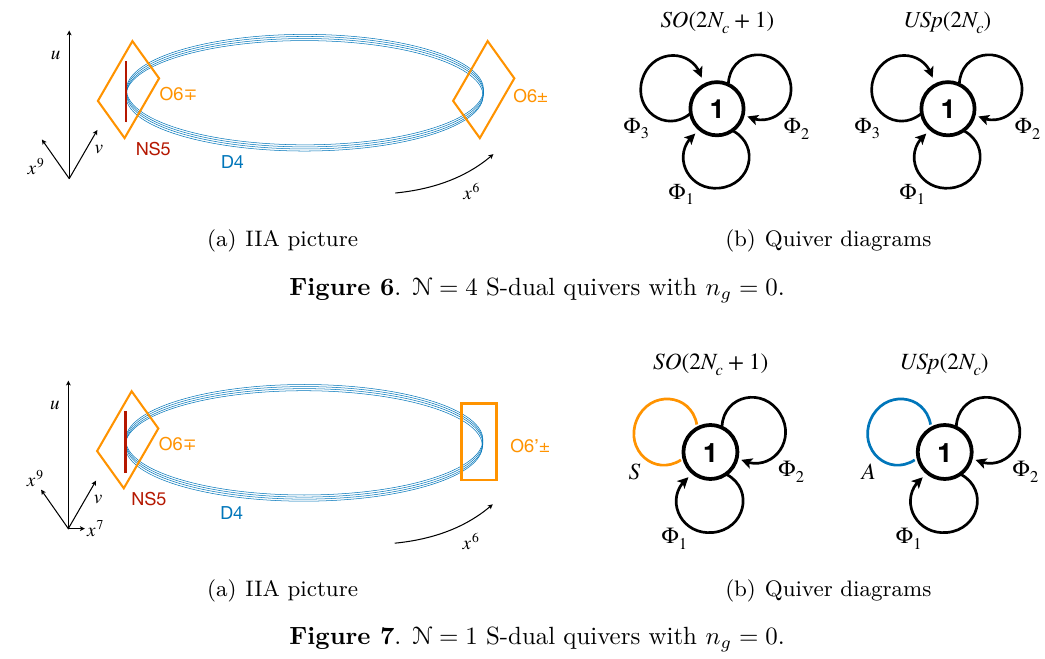
Figure 7 . N = 1 S-dual quivers with n g = 0